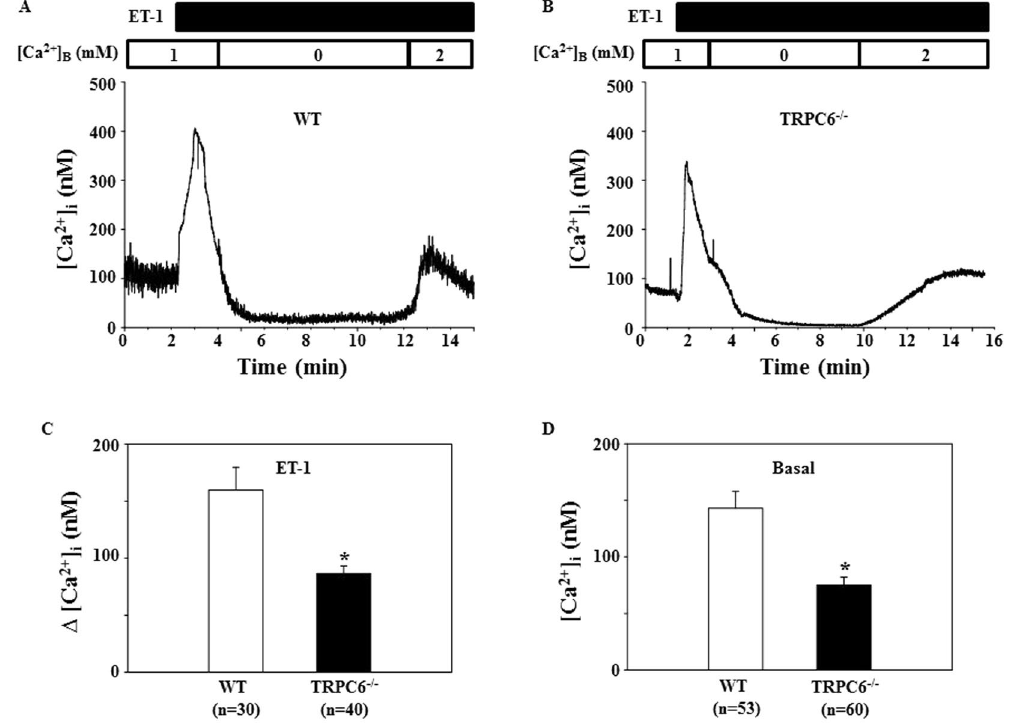
Figure 8. Endothelin-1-induced Ca 2 + response in primary mouse MCs. ( A and B ) Representative traces, showing [Ca 2 + ] i in response to 100 nM endothelin-1 (ET-1) in the MC isolated from a WT ( A ) and TRPC6 − / − ( B ) mouse. [Ca 2 + ] B indicates the Ca 2 + concentration in bathing solution. Application of ET-1 is indicated by a horizontal bar at the top. ( C ) Summarized Ca 2 + entry response from experiments presented in A and B. 2 + ] 2 + to the bath from the peak Δ [Ca 2 + ] i was calculated by subtracting [Ca i before re-addition of 2 mM Ca [Ca 2 + ] i after re-addition. The numbers inside the parentheses represent the number of cells analyzed from 6 WT and 6 KO mice. * P < 0.05, compared to both WT. ( D ) The basal [Ca 2 + ] i (before administration of Ang II in Fig. 6 and ET-1 in Fig. 7A–C) in TRPC6 − / − and WT mouse MCs. “n” indicates the number of cells analyzed in each